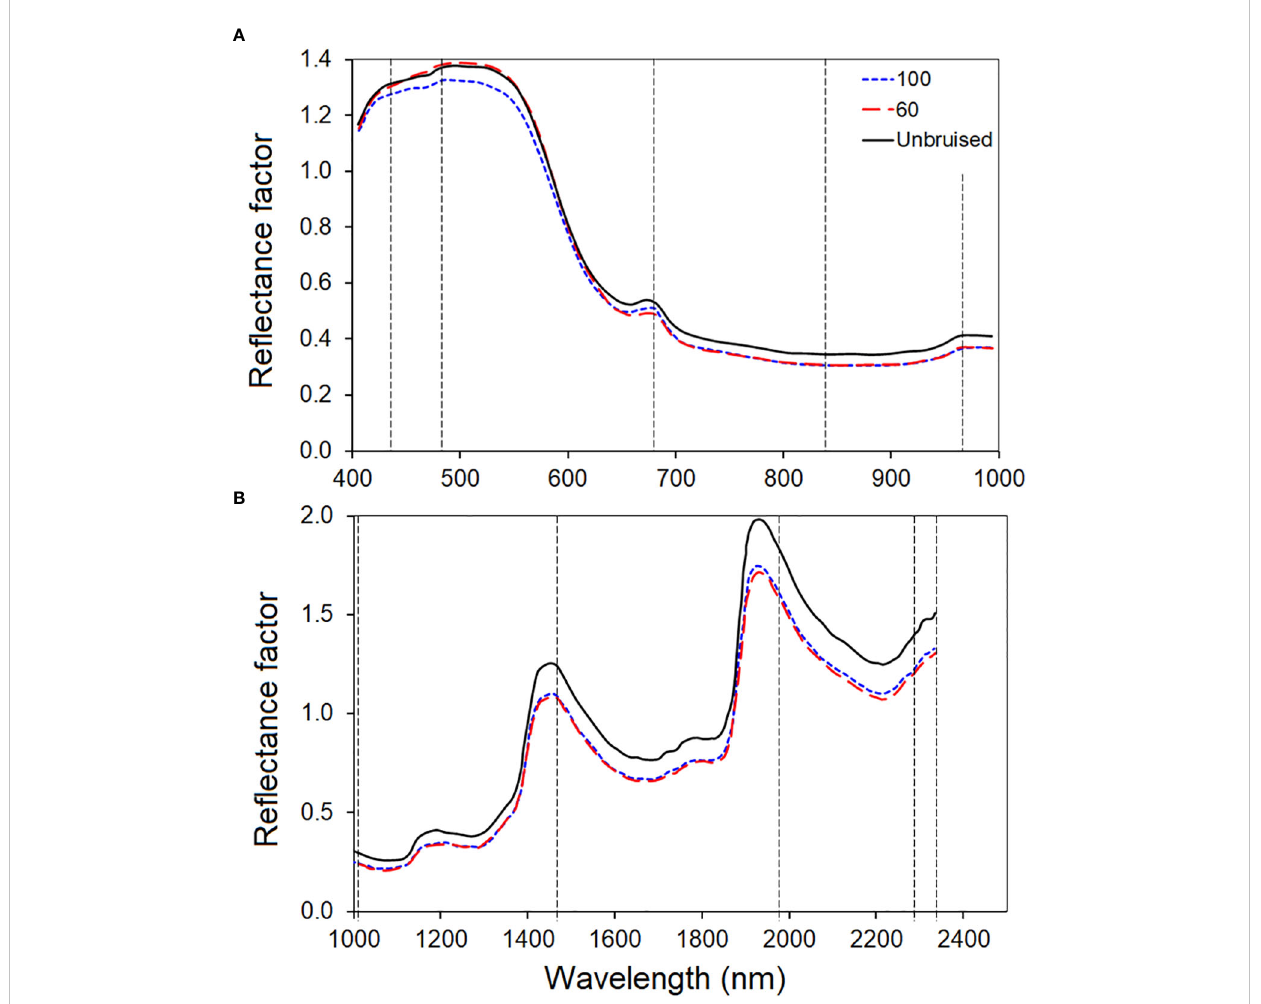
FIGURE 8 The average class spectral of the three bruise severity classes of the VNIR (A) and SWIR (B) camera. The vertical dashed lines identi fi ed the most informative bands selected by the effective wavelength (407, 639 and 917nm) selected using the noise-whitened Harsanyi – Farrand – Chang (NWHFC)